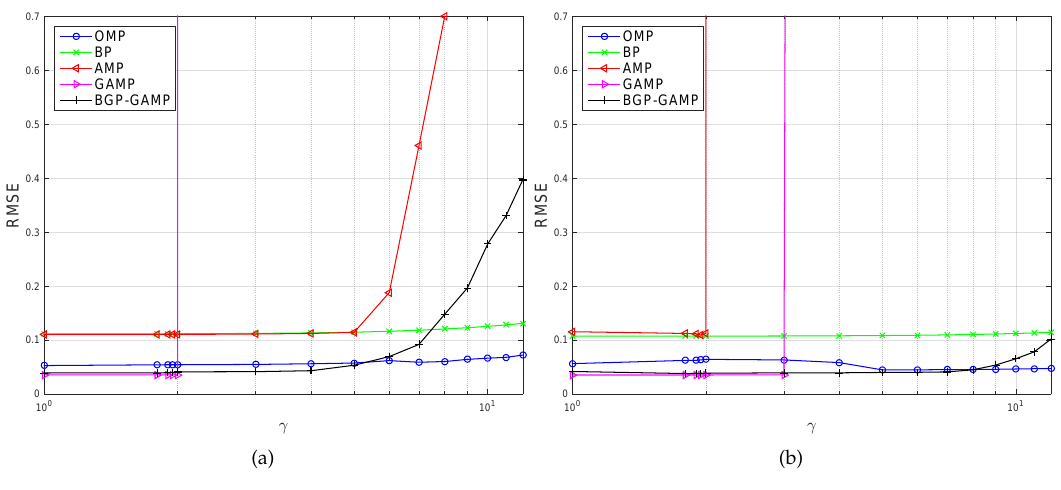
Figure 1. Reconstruction performance comparison of the Non-zero mean sensing matrix. ( a ) Type-1 sensing matrix; ( b ) Type-2 sensing matrix.